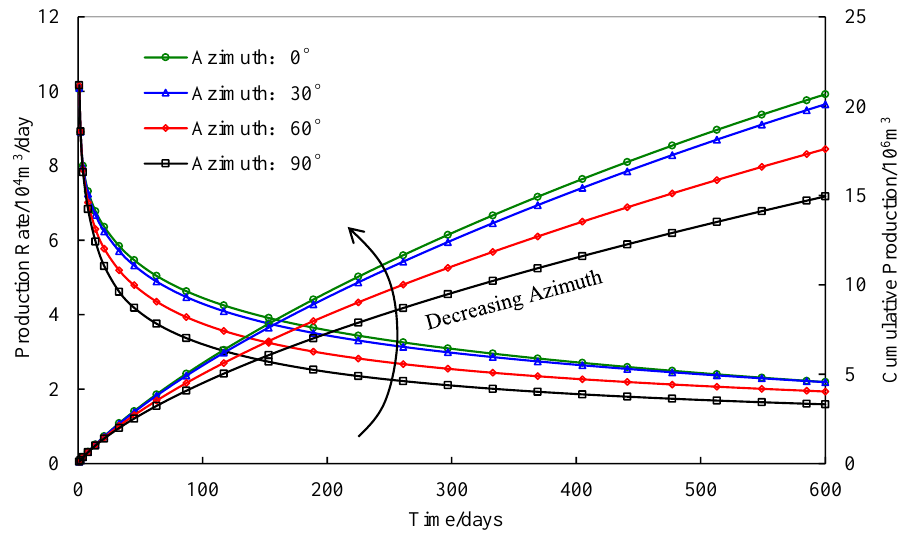
Figure 10. Effect of azimuth on gas production rate and cumulative production (decline curves represent gas production rate curves, increasing curves represent cumulative production curves).